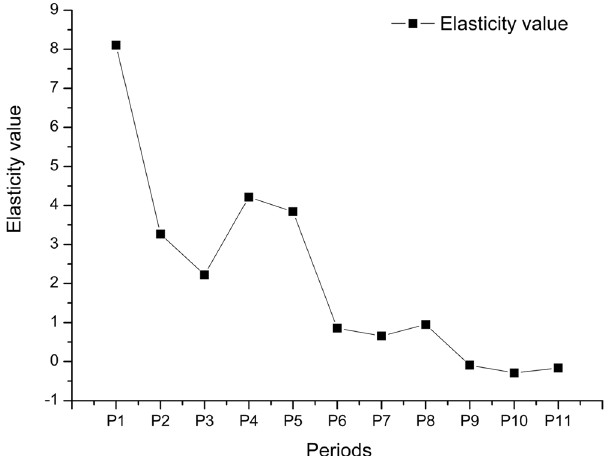
Figure 4. Change in elasticity value between coastal reclamation area and GDP with